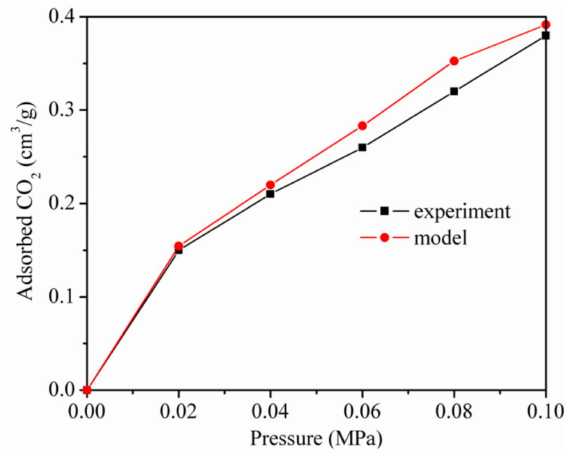
Figure 1. Adsorption isotherms of CO 2 in terms of the simulation results and the experimental results at 298.15